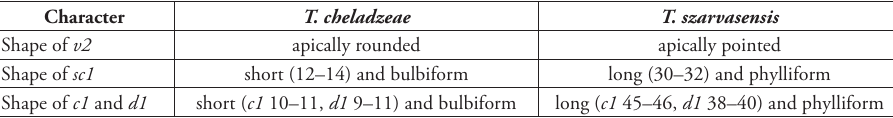
Table 3. Distinguishing characters between Tenuipalpus cheladzeae and T. szarvasensis